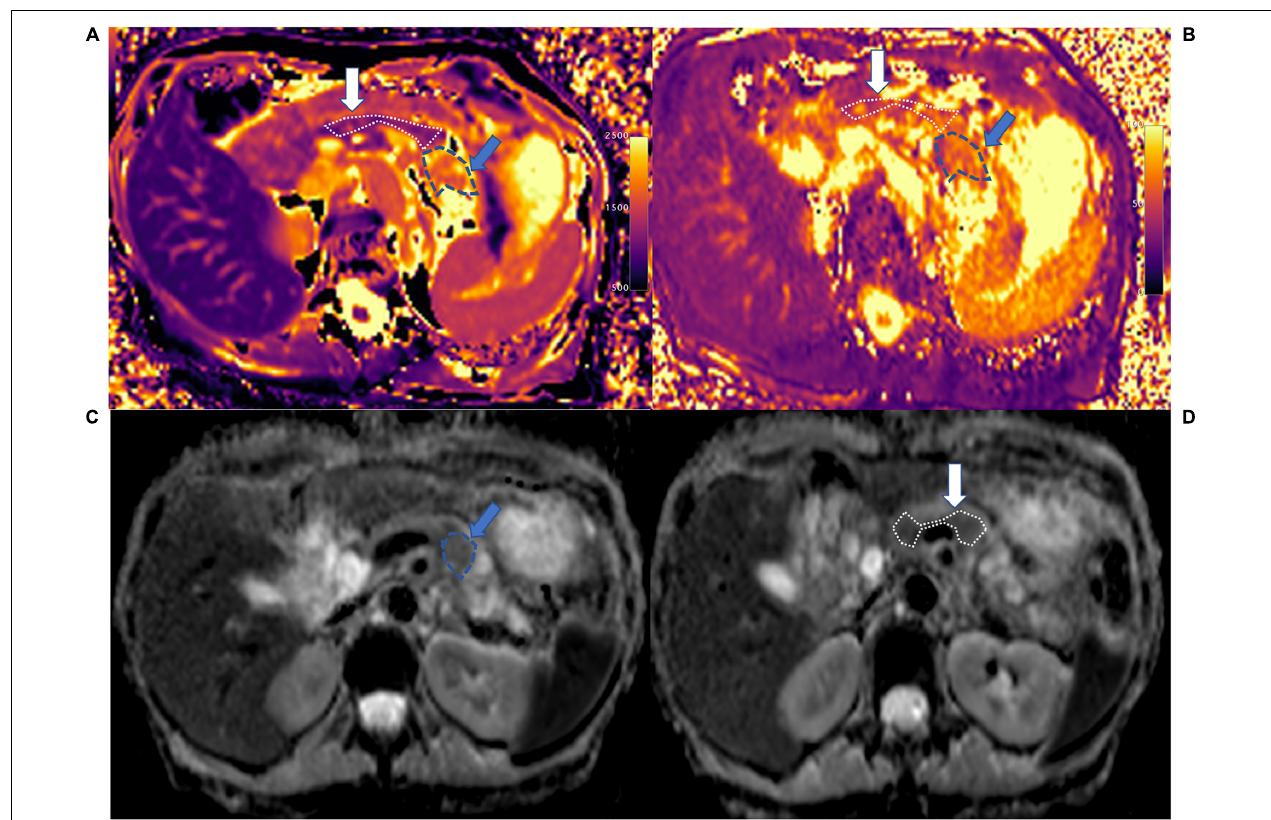
FIGURE 2 | T1 mapping (A) , T2 mapping (B) , and ADC maps (C,D) of PDAC (blue arrow and area) and downstream pancreas (white arrow). PDAC shows higher T1 (1,867.3 ± 163.7 ms), T2 (69.5 ± 6.0 ms), and ADC values (1.857 ± 0.231 mm 2 /s) compared to downstream pancreas. The downstream pancreas shows homogenous T1 (1,266.4 ± 106.9 ms), T2 (62.7 ± 6.3 ms), and ADC (1.315 ± 0.173 mm 2 /s) values. A clear interface is seen between the tumor and downstream